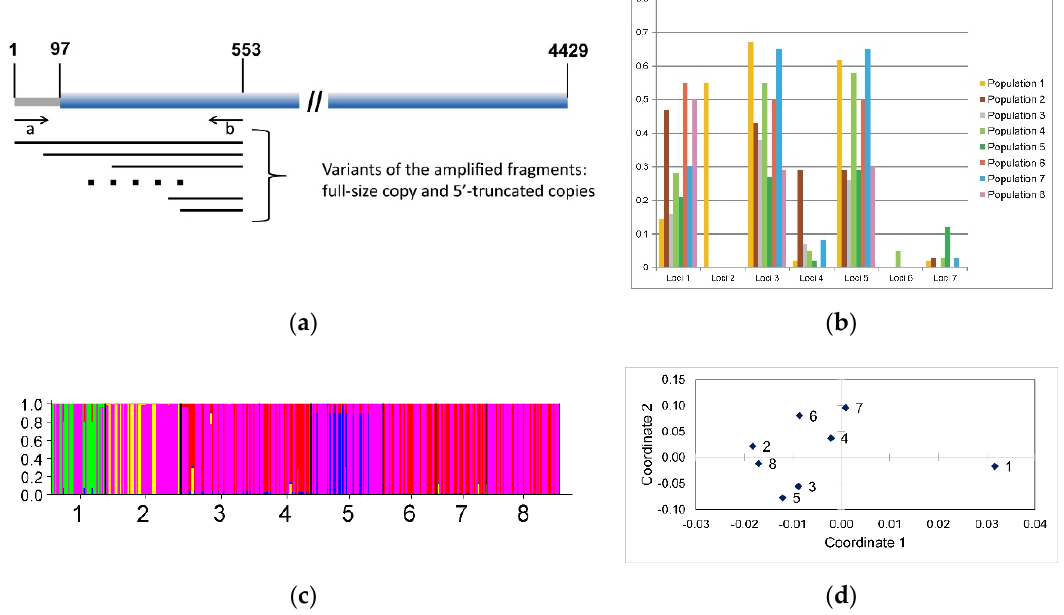
Figure 6. Analysis of the structural variants of R2 retrotransposon 5 (cid:48) -truncated copies aimed at assessing the transpositional activity of these TEs and the structure of B. germanica populations. ( a ) Schematic illustration of the structure of R2 retrotransposons, including the 5 (cid:48) -end environment. The position of the primers ( a , b ) used to identify the 5 (cid:48) -truncated copies of the R2 retrotransposon is indicated. The numbers indicate the positions of the corresponding nucleotides; ( b ) The frequency of the occurrence of the described 5 (cid:48) -truncated copy variants (Loci 1–7) in eight studied populations; ( c ) Bayesian genotypic cluster analysis based on the frequency of the occurrence of the described variants of 5 (cid:48) -truncated copies of the R2 retrotransposon of B. germanica in the eight populations together at K = 5. Each cluster is designated with a particular color (see Table 2). x -axis, samples collected in population ## 1–8; ( d ) Principal coordinate analysis (PCoA) of eight cockroach populations based on Nei’s genetic distances. PCoA plot in which the eight cockroach populations are plotted according to the eigenvectors corresponding to the first and second principal coordinates. Theamplificationresultswereanalyzedbyordinaryacrylamidegelelectrophoresis. Only